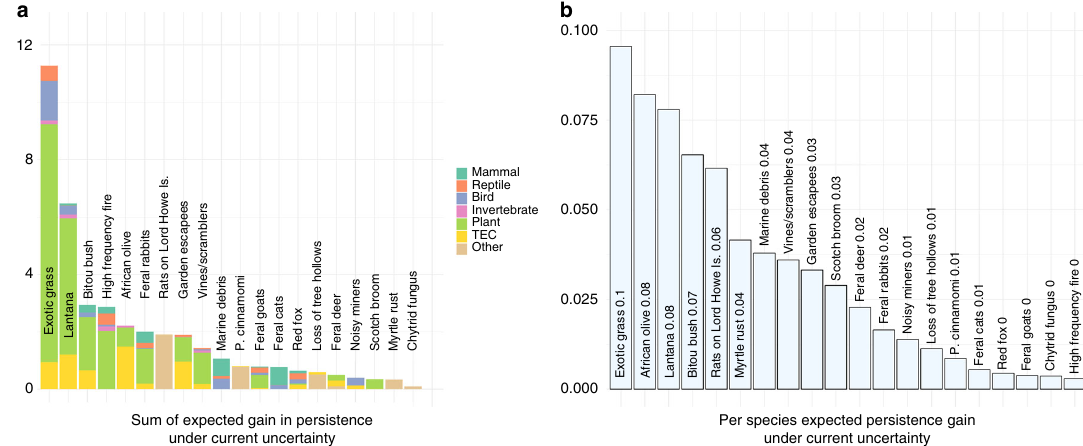
Fig. 1 Expected gain in persistence from management for each threat under current uncertainty. Gain is computed relative to taking no action. Panel a depicts the total gain in persistence for all species affected by the threat; colours depict the proportional contribution to the sum from groups of affected species. Panel b depicts the mean per-species gain in persistence. Quantities in the bar labels are rounded to two decimal